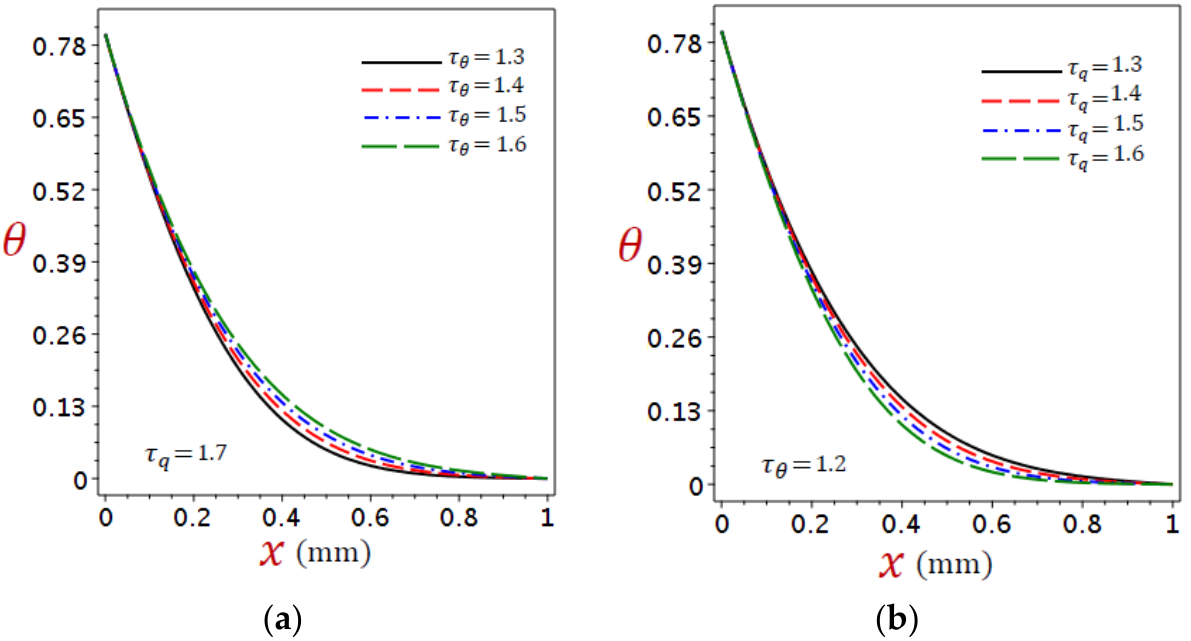
Figure 10. Distributions of temperature ( θ ) for refined DPL model under ( a ) different τ θ with τ q = 1.7 and ( b ) different τ q with τ θ = 1.2 .